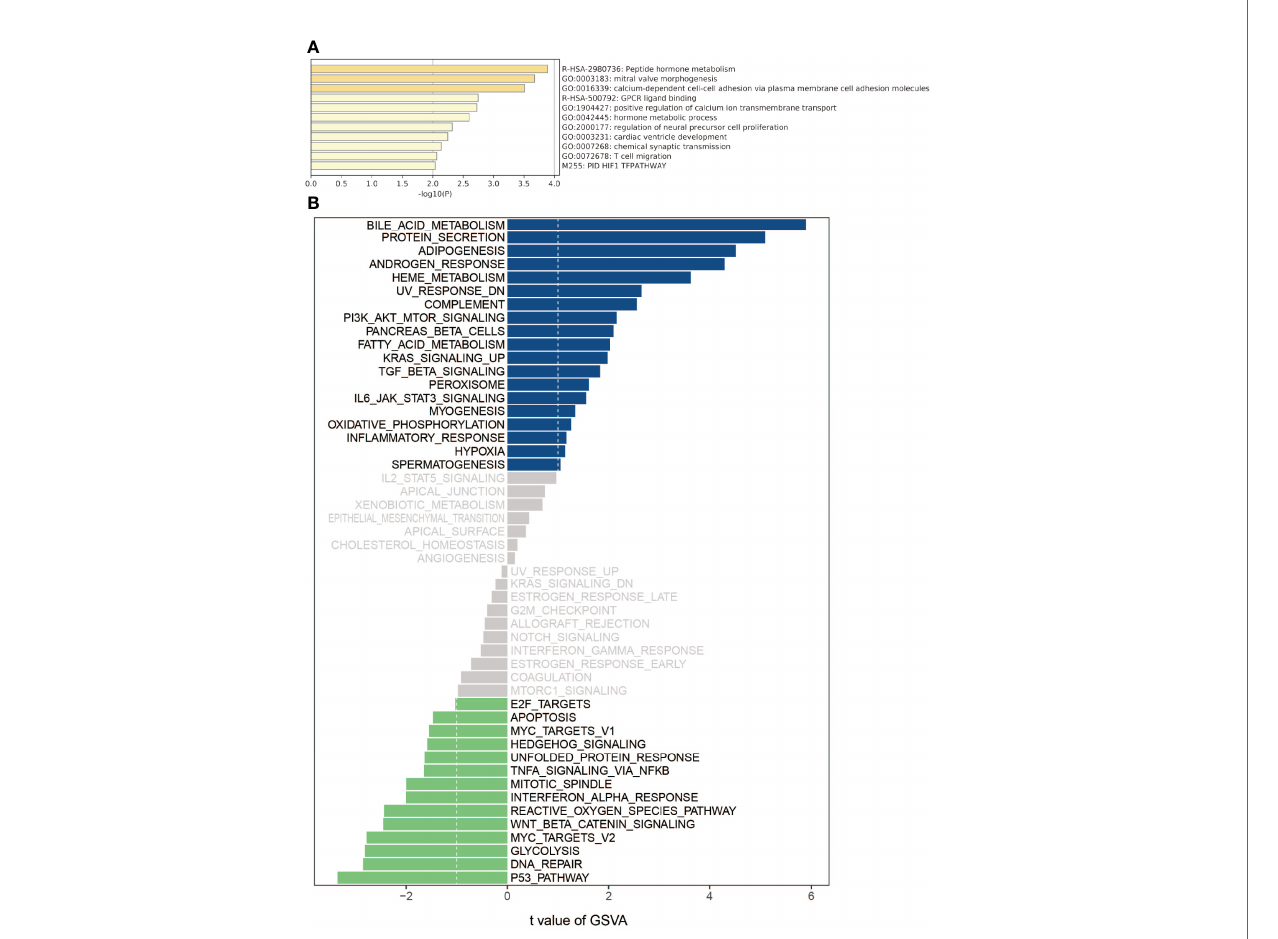
FIGURE 2 | Gene ontology (GO) and gene set variation analysis (GSVA). (A) Using the Metascape database for annotation and visualization, GO analysis was performed on the ARHGAP4 enrichment correlation genes from the brown module. (B) GSVA divergence bar chart. Using GSVA, the signal pathways of the ARHGAP4 enrichment correlation genes. Bar graph of enriched terms across input gene lists, colored by